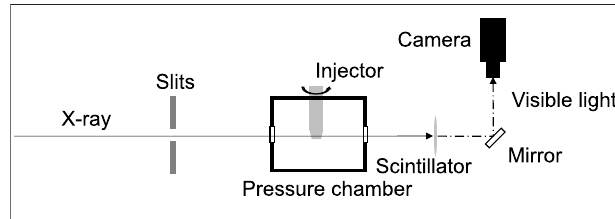
FIGURE 1 | A schematic of the injection experiment and X-ray diagnostic setup.